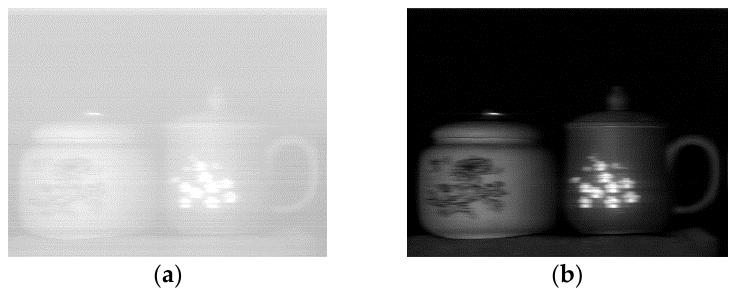
Figure 5. Sample synthesized image. ( a ) Result before the removal of back scattered light. ( b ) Result after the removal of back scattered light.